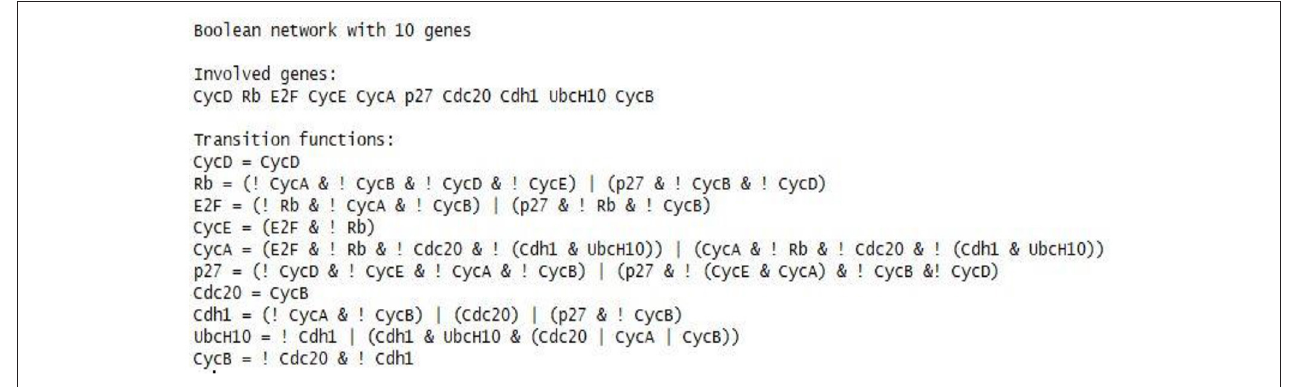
FIGURE 8 | Known mammalian cell cycle networks provided by BoolNet .